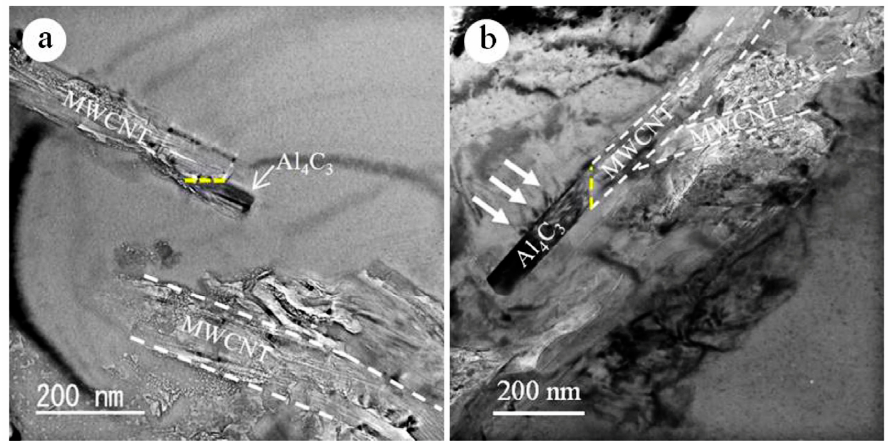
Figure 14. HRTEM (High resolution transmission electron microscope) images of MWNT (multi-walled nanotubes)-reinforced Al matrix nanocomposites heat treated at: ( a ) 873 K for 6 min and ( b ) 883 K for 60 min [132] (Adapted with permission from [132], Elsevier, 2016).